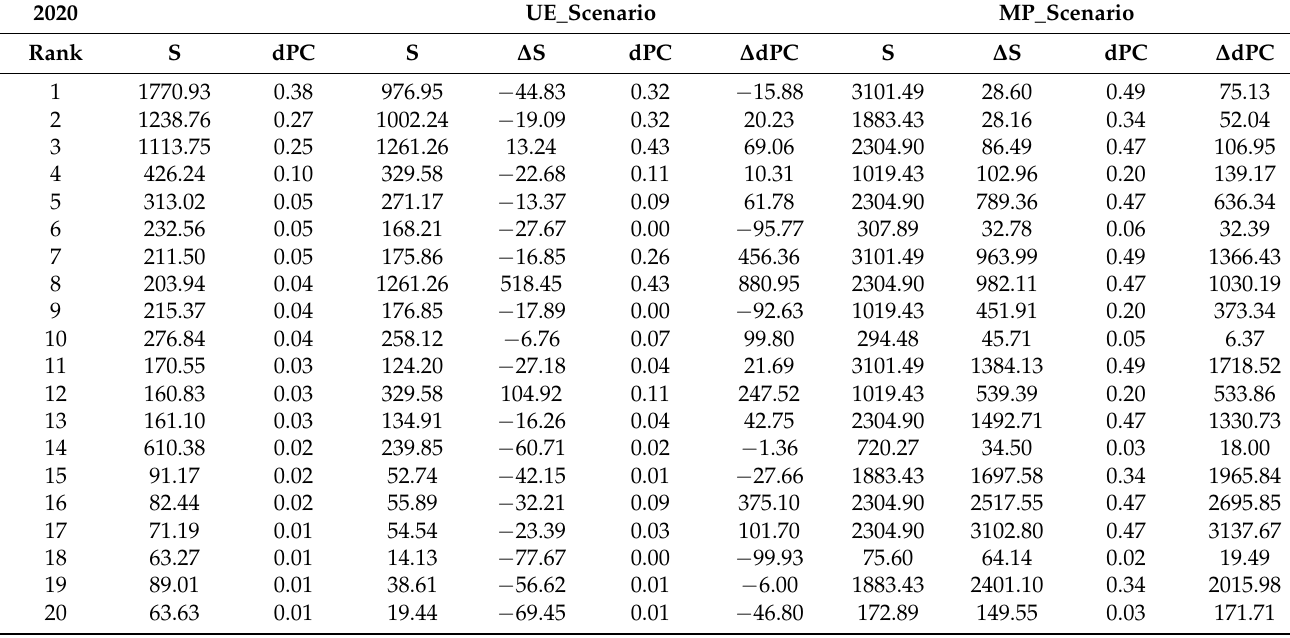
Table A3. Data statistics of top 20 patches of dPC